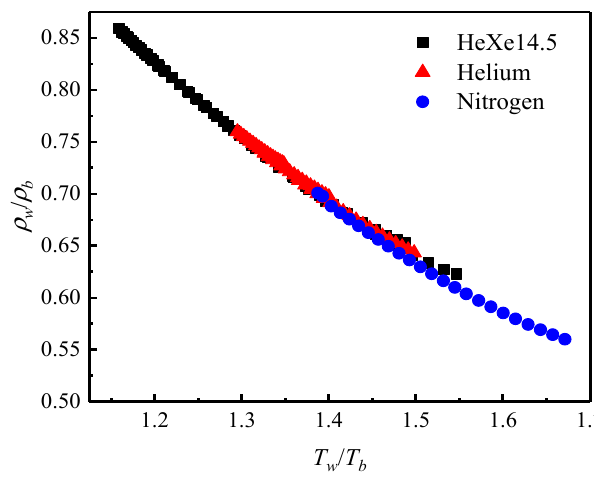
Figure 9. Variation of ρ w / ρ b with T w / T b for different gases.